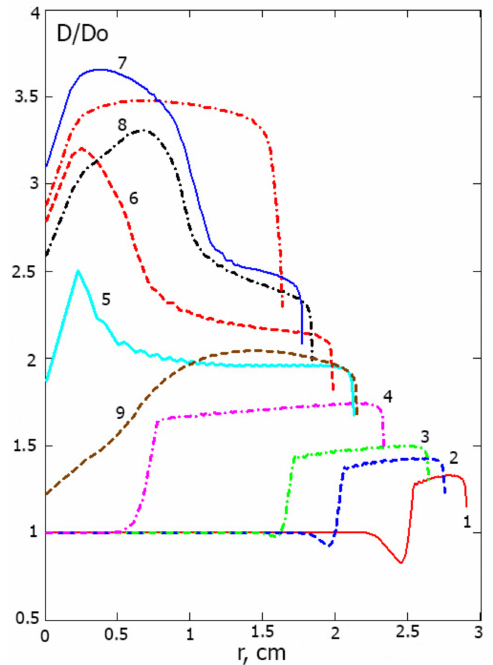
Figure 5. Density distributions of the plasma compressed by the shell at different times; t , ns: 1–50, 2–80, 3–100, 4–150, 5–180, 6–200, 7–220, 8–260,